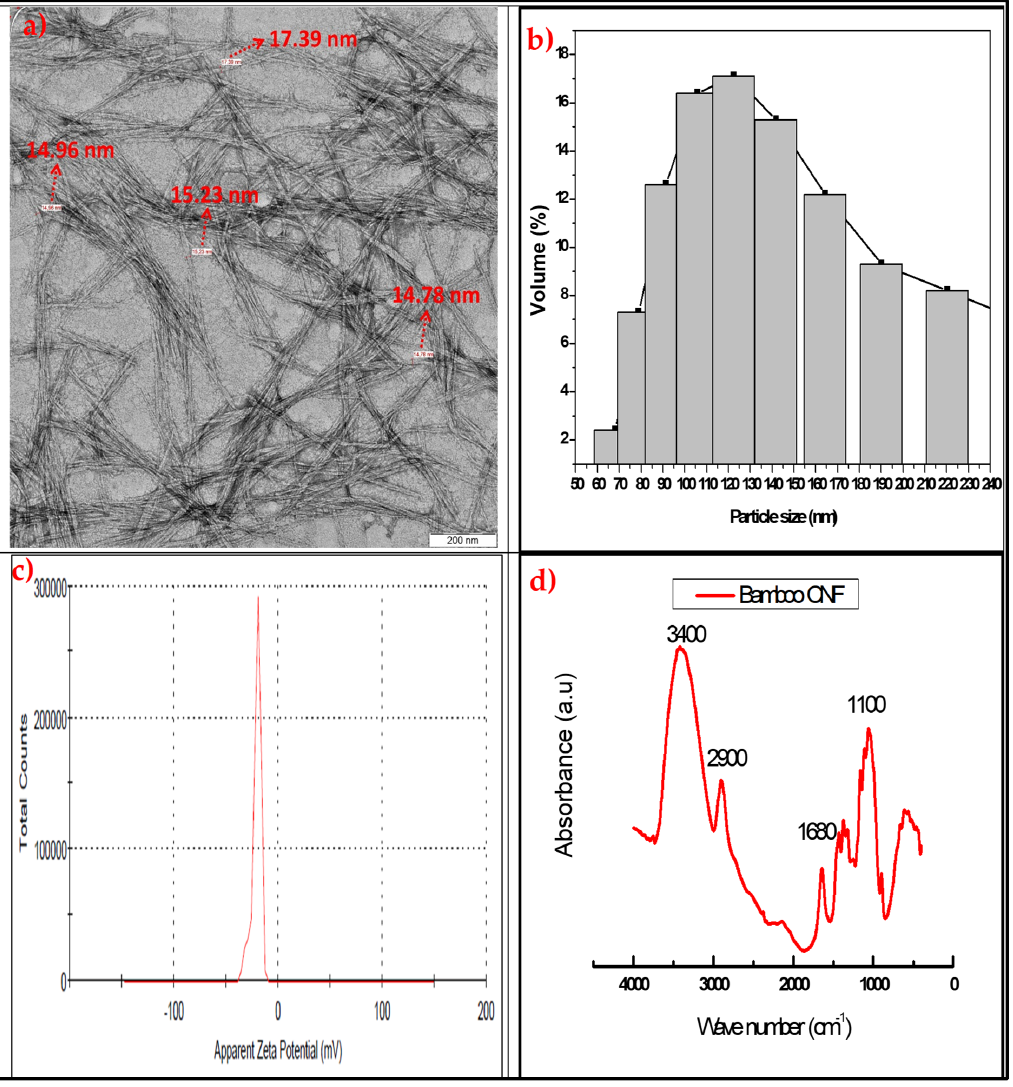
Figure 1. ( a ) TEM, ( b ) particle size analysis, ( c ) zeta potential, and ( d ) FT-IR analysis of Schizostachyum brachycladum bamboo cellulose